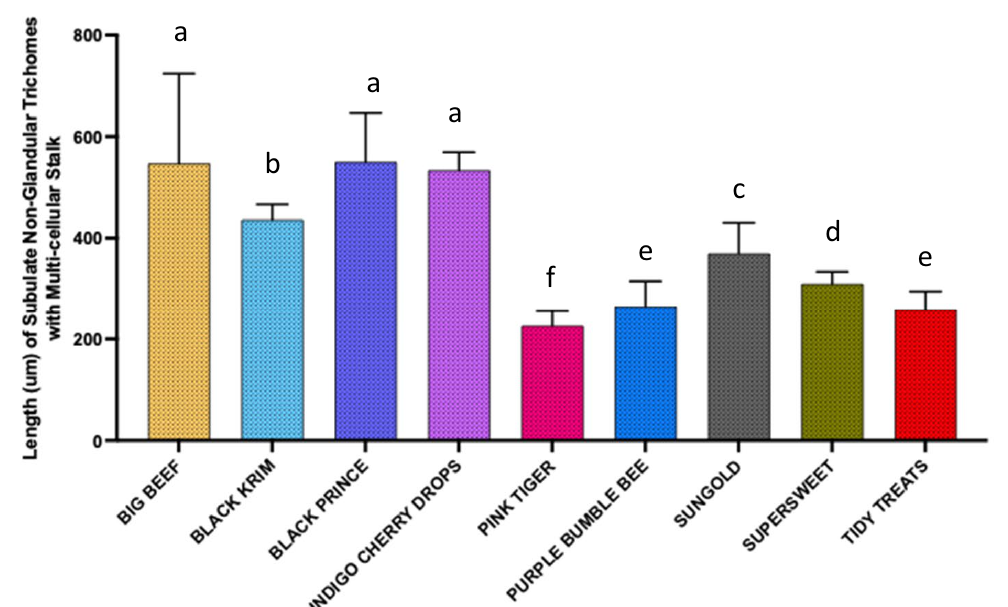
Fig. 12 Comparison of length (µm) of second common non-glandular trichome (subulate non-glandular hair with multicellular jointed stalk, multicellular base, and distinct subsidiary cells) in ten varieties of tomato